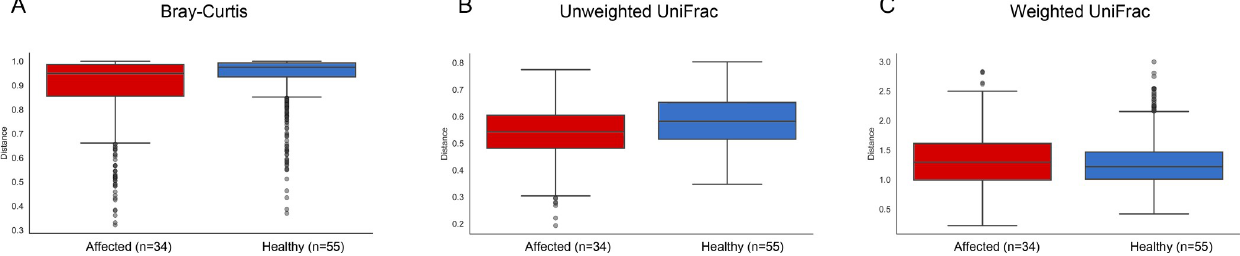
Fig 5. Beta diversity analysis between healthy and affected dogs. Bray Curtis (A), Unweighted (B) and Weighted UniFrac (C) distance matrices present an intra-group variation in healthy and affected dogs.